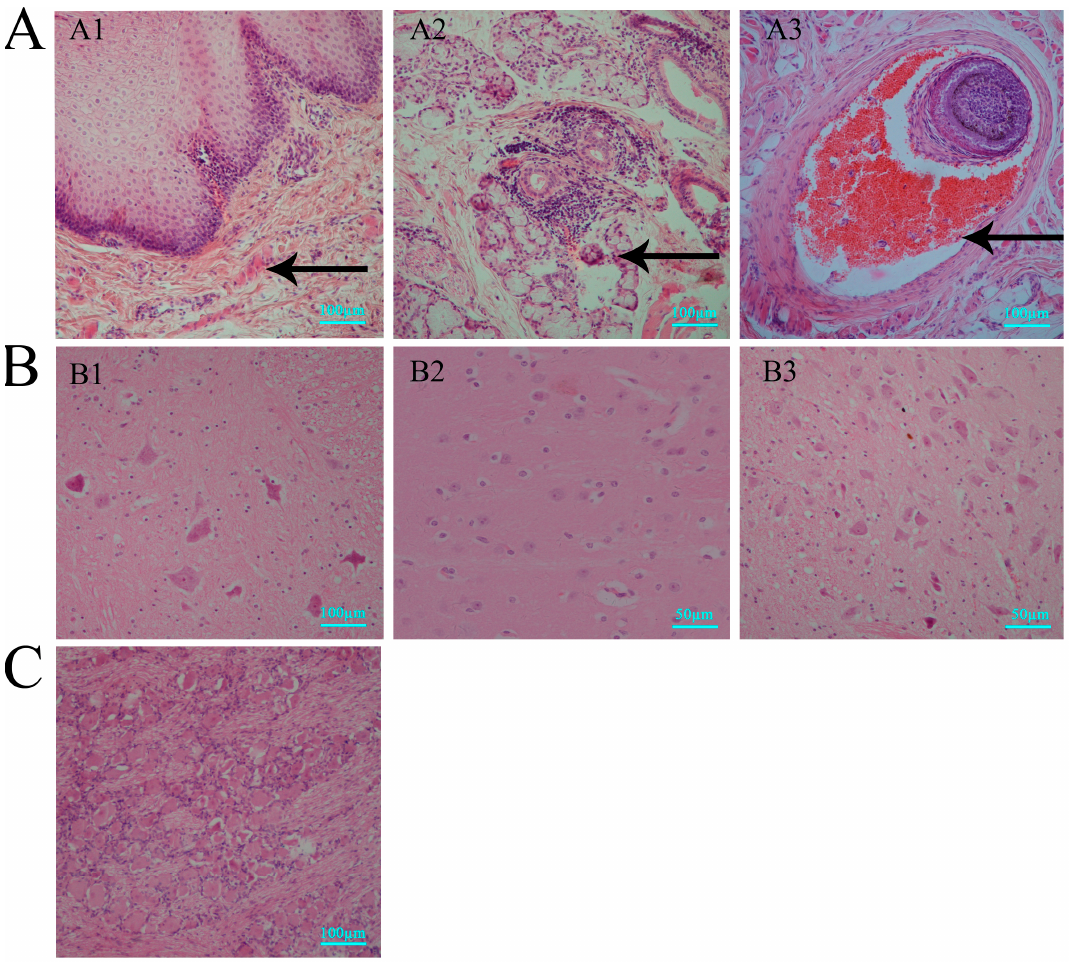
Figure 2. Pathological features of macaques in acute HSV1 infection. ( A ) vesicular lesions in oral skin of the epidermis (A1) (#14065), sebaceous glands (A2) (#14065) and hair follicle (A3) (#14137), structural damage and obvious inflammatory cell infiltration underneath in A1 and A2, and hyperemia in A3; ( B ) nervous tissues, including spinal cord (B1) (#14065), thalamus (B2) (#14065) and mesencephalon (B3) (#14137); no obvious structural damage was observed; ( C ) pathological analysis of TG (#14065); no pathological changes. Positive pathological changes are indicated by black arrows. Scale bars = 50 µ m in B2, and B3, scale bars = 100 µ m in A, B1, and C.